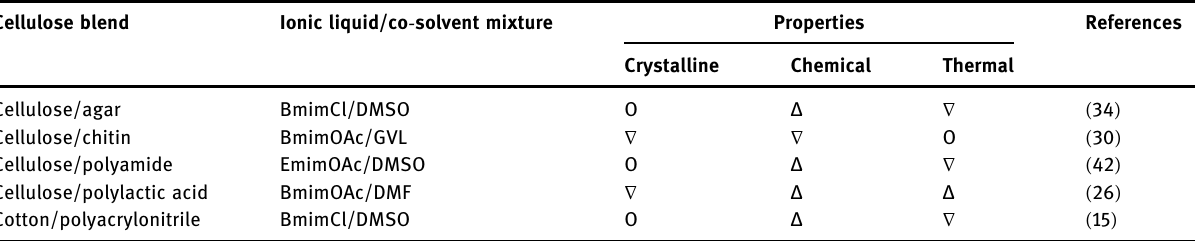
Table 8: Crystalline, chemical, and thermal properties of cellulose blends regenerated from cellulose blend/imidazolium - based ionic liquid/co - solvent solutions Cellulose